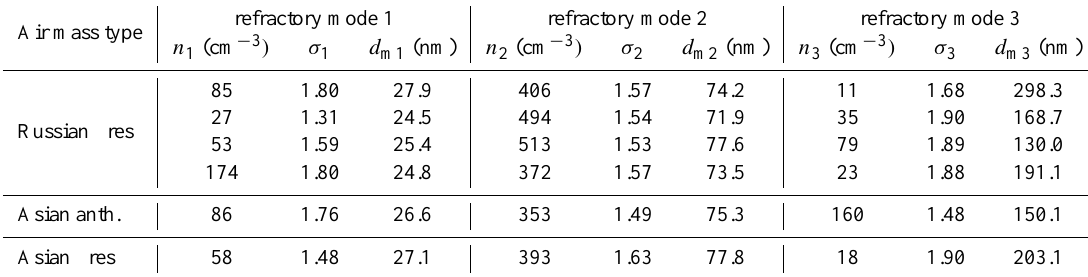
Table 6. Parameterisation of log-normally fitted refractory size distributions for forest fire